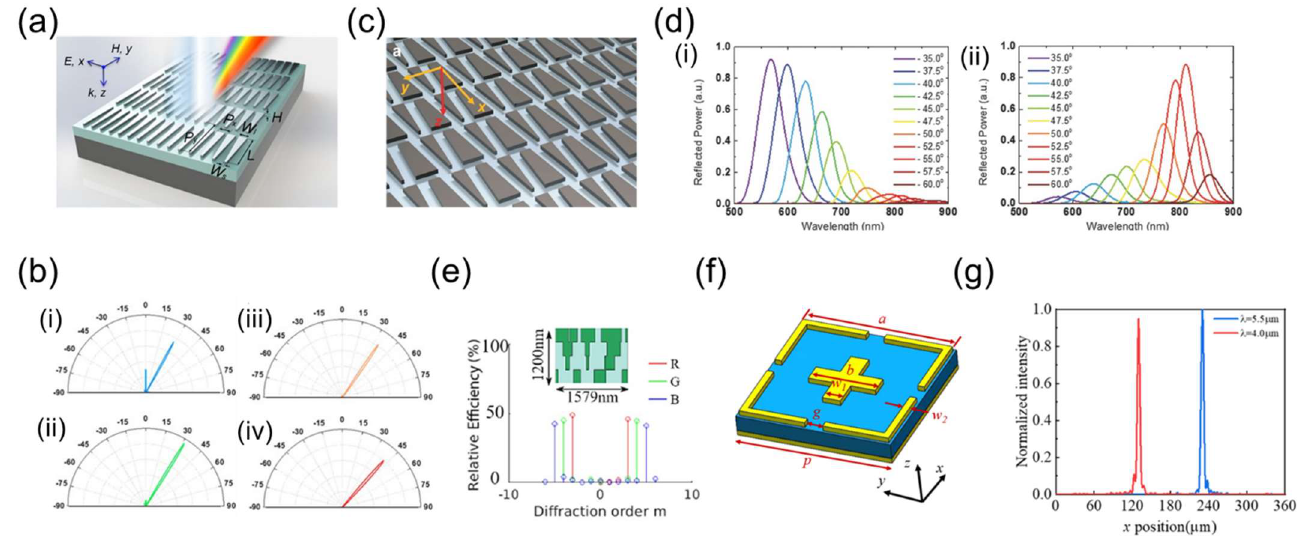
Figure 13. ( a ) A metasurface consisting of a trapezoidal silver plasmonic antenna array and a broadband gradient interfacial phase shift in arbitrarily curved reflection directions. Reprinted with permission from [122]. Copyright 2015 American Chemical Society. ( b ) Near-field profiles and wavefronts of reflected waves above the metasurface at 480 ( i ), 520 ( ii ), 560 ( iii ), and 660 nm ( iv ), respectively, and a polar plot of the far–field reflectance spectrum for the corresponding wavelength. Reprinted with permission from [122]. Copyright 2015 American Chemical Society. ( c ) A multifunc- tional metasurface composed of two different trapezoidal nanoantennas [123]. Copyright 2016 John Wiley and Sons. ( d ) The reflected power spectra measured at different reflection angles of −35°–−60° ( i ) and 35°−60° ( ii ), respectively [123]. Copyright 2016 John Wiley and Sons. ( e ) Schematic diagram of the relative efficiency and structure of the beam splitter [124]. ( f ) Schematic diagram of the unit cell for the design of the hybrid antenna structure [125]. ( g ) Light intensity distribution at the focal plane at incident wavelengths λ = 4.0 and 5.5 μm [125]. Table 6. Parameters of wavelength metasurface beam splitters described in this section.